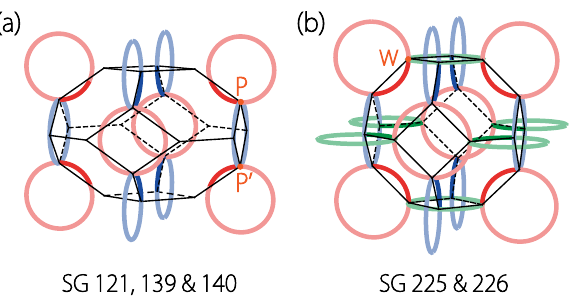
Fig. 1 Symmetry-enforced nodal chains for the fi ve candidates SGs. a SG 121, 139, and 140 host nodal chains running along the fourfold S 4 z axis. b In SG 225 and 226, there are chains running along all three directions, forming a network structure. Here, the rings with different orientations are marked with different colors.